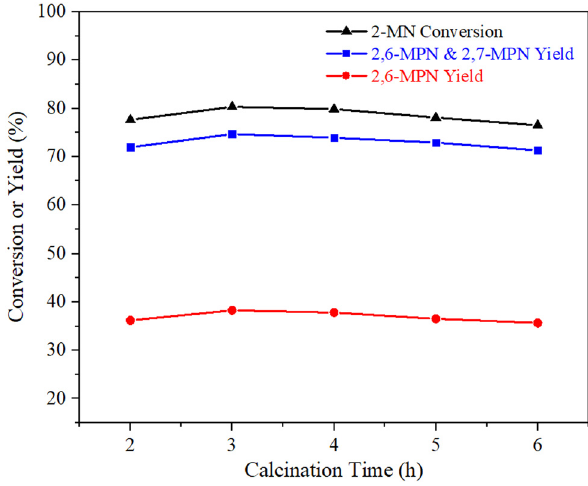
Figure 10: In fl uence of catalyst dosage on 2 - MN propionylation reaction. Reaction conditions: n ( 2 - MN ) : n ( PA ) = 1:1.8, TS 10 g, AlCl 3 /H β ( AlCl · L − 1 , re fl ux for 9 h and calcination at 550°C for 3 h ) , 3 3 g 190°C, 10